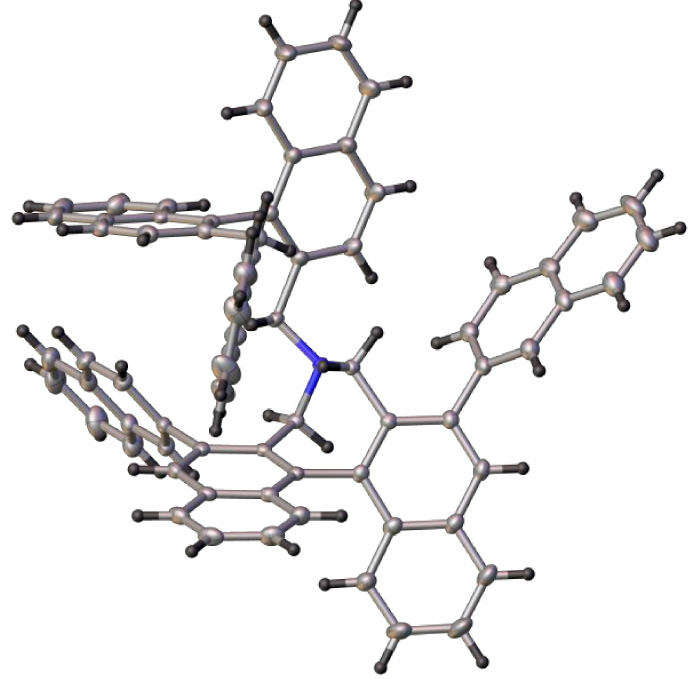
Figure 2. X-ray structure of 17b